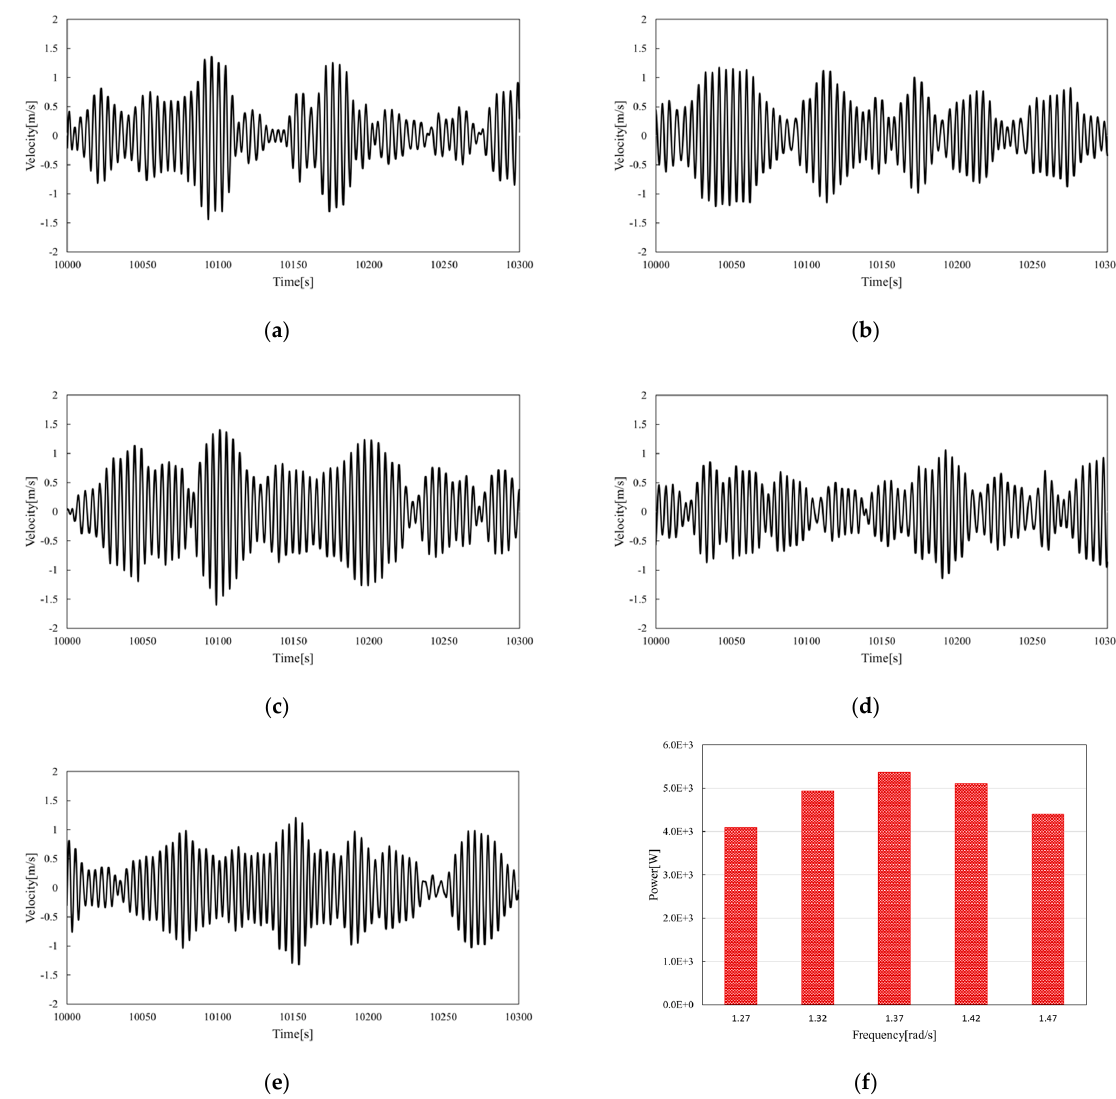
Figure 13. Comparison of velocity and power generation of floaters with different sizes under irregular waves: ( a ) ω = 1.27 rad/s; ( b ) ω = 1.32 rad/s; ( c ) ω = 1.37 rad/s; ( d ) ω = 1.42 rad/s; ( e ) ω = 1.47 rad/s; ( f ) power comparison.